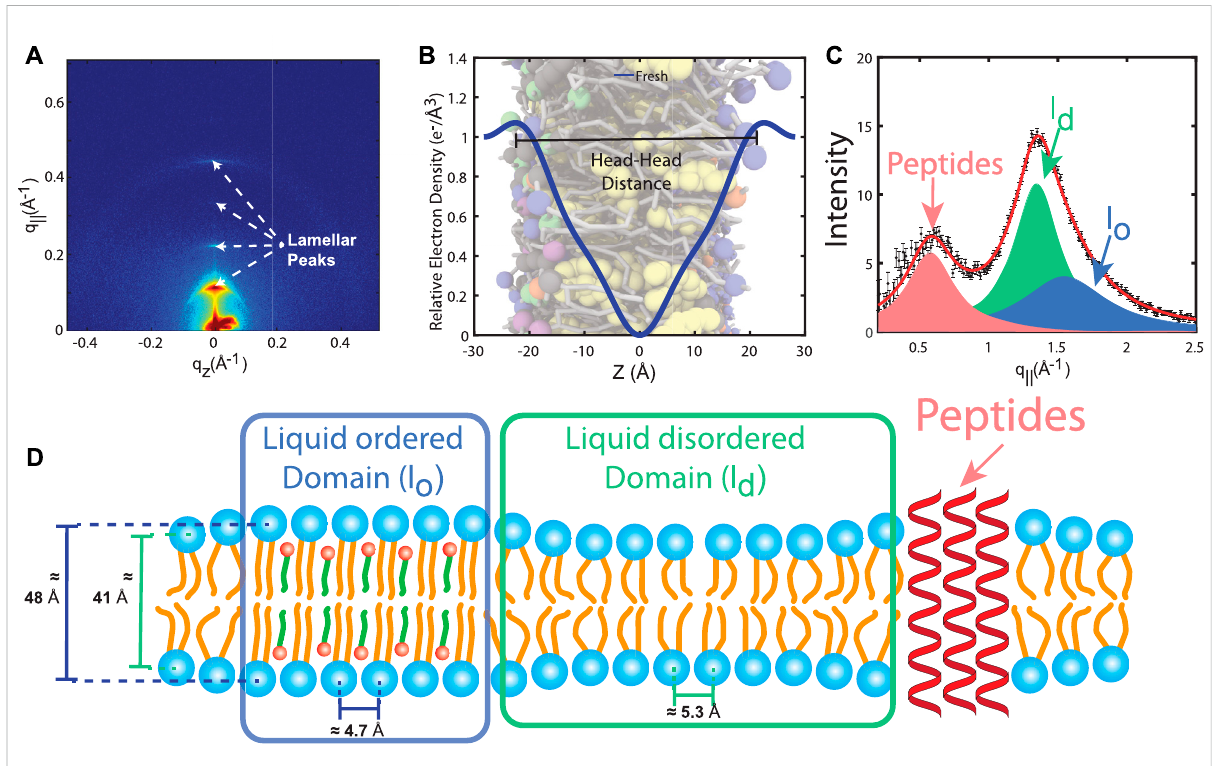
FIGURE 3 (A) Two-dimensionalX-rayintensitymaprecordedonastackofRBC cm ,measuredat37 ° Cand88%relativehumidity.Thelamellarpeaksarethe result of the lamellar stacking of the membranes. (B) Electron density pro fi le reconstructed from the specular peak intensities. The pro fi le is characterized by a global minimum in the bilayer center and two maxima that indicate the location of the electron rich phosphate group of PLs and SMs. (C) In-plane X-ray scan reveals three signals that can be assigned to liquid ordered l o , liquid disordered l d and peptide domains. (D) Schematic of the RBC cm structure, as determined from the high-resolution X-ray diffraction